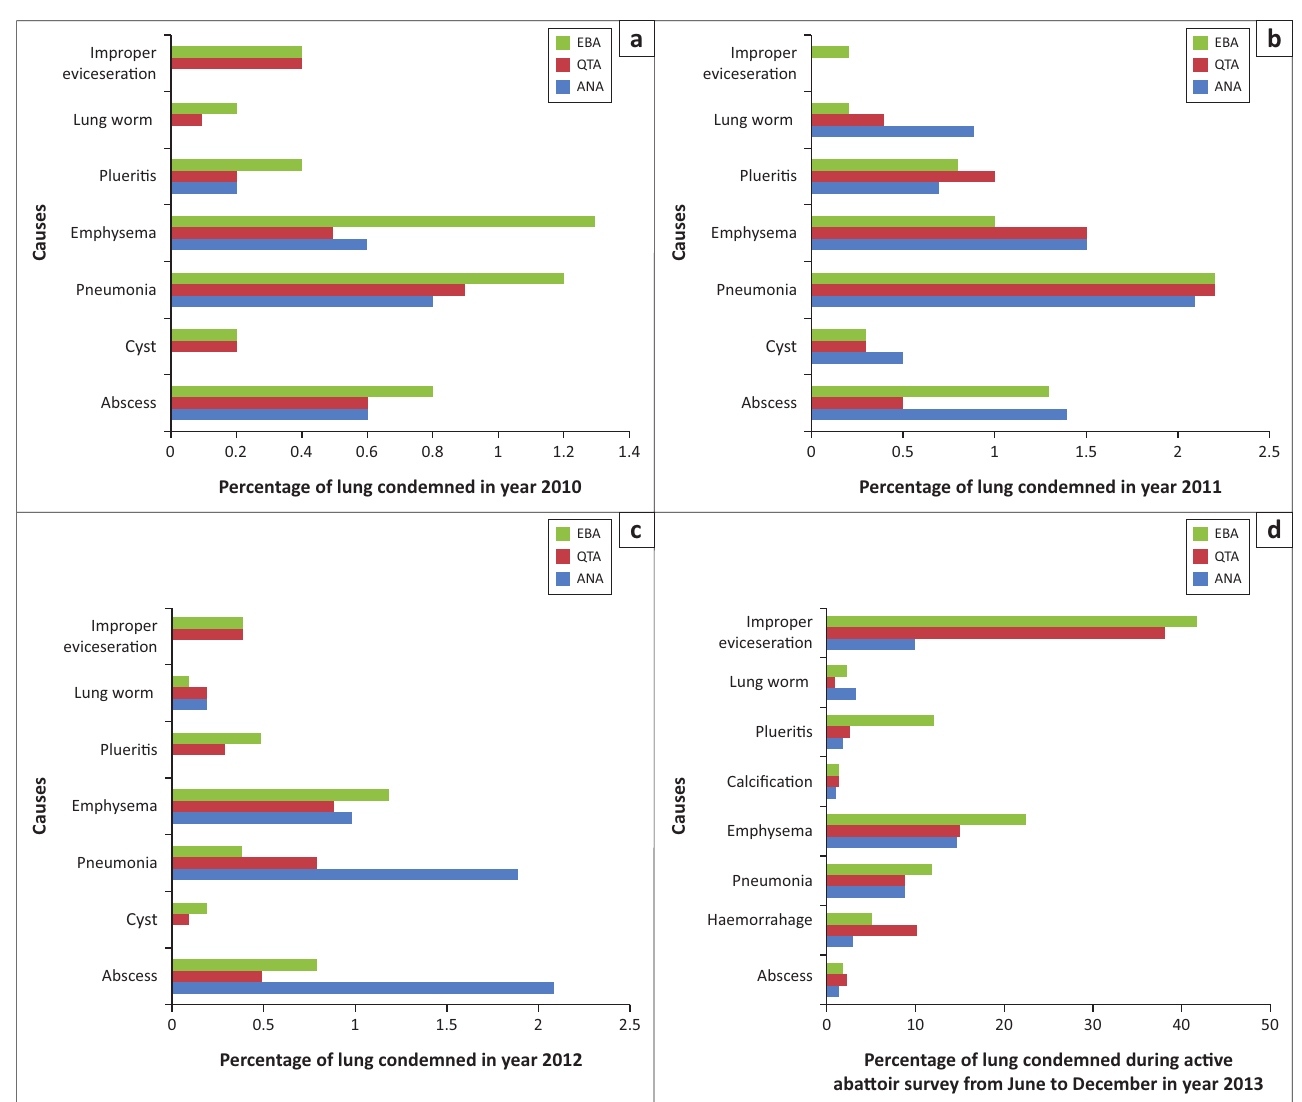
FIGURE 1: Causes ( % ) of cattle lung condemnations in the Eastern Cape Province South Africa. For the year (a) 2010, (b) 2011, (c) 2012 and (d)